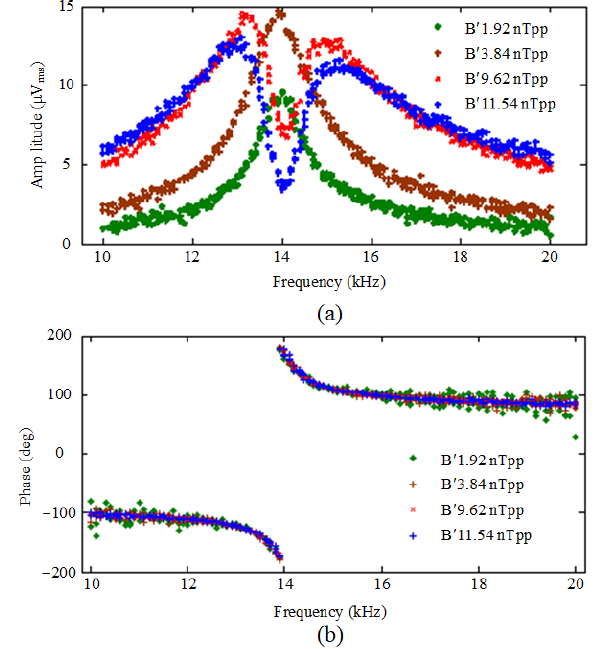
Fig. 1 Experimental magnetic resonance responses: (a) amplitude-frequency responses of a K magnetometer acquired experimentally under 170 ℃ , with the pumping power of 109 μ W, a static field B z of 2000 nT and four transverse oscillation fields B ′ : 1.92 nT pp in green, 3.84 nT pp in brown, 9.62 nT pp in red, and 11.54 nT pp in blue and (b) phase-frequency curves under the same